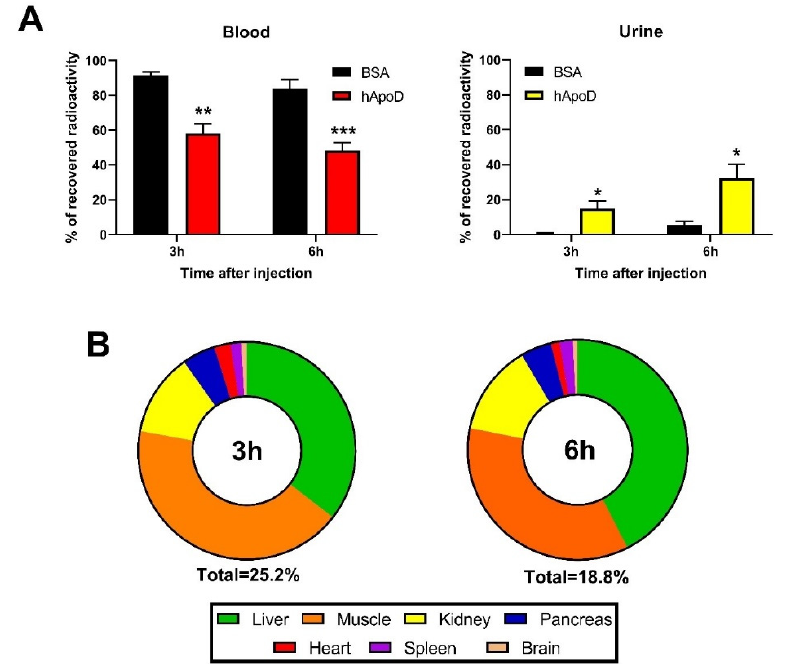
Figure 3. Relative accumulation of hApoD in fluids and tissues. Radiolabeled proteins (Bovine Serum Albumin (BSA) and hApoD) were injected intravenously in mice. Blood, urine, and—after perfusion—organs were collected 3 and 6 h post-injection. Results are presented for each ( A ) fluid and ( B ) organs as their average respective percentage of the total radioactivity recovered in the animals. Statistical significance was evaluated via a Student t-test: * p < 0.05, ** p < 0.01, *** p < 0.001 (n = 4 animals).